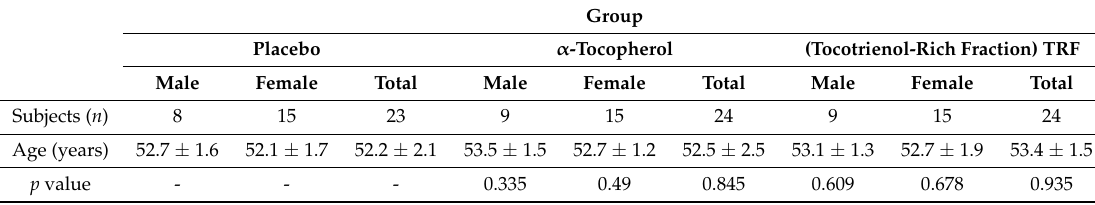
Table 1. Baseline and intervention characteristics of the subjects.